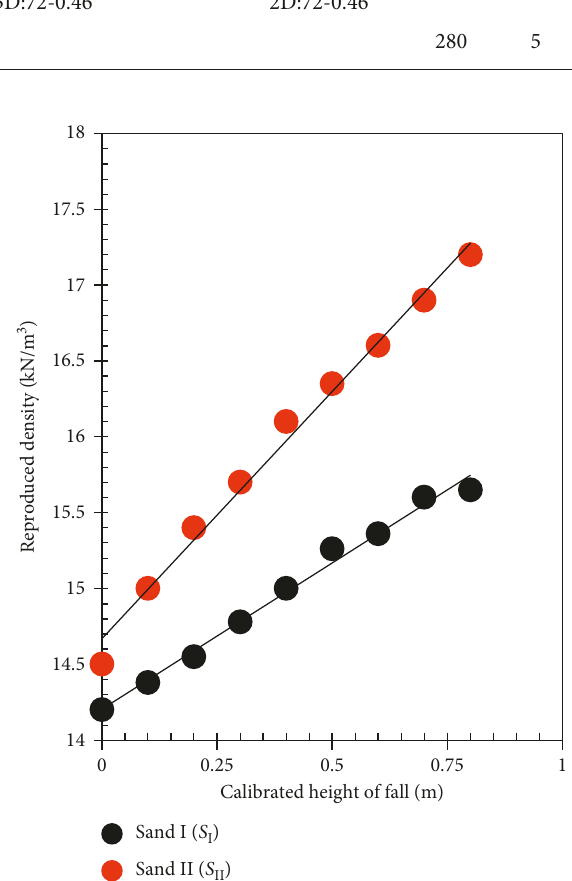
Figure 2: Reproduced density vs. calibrated height of fall relation of sand I ( S I ) and sand II ( S II ).